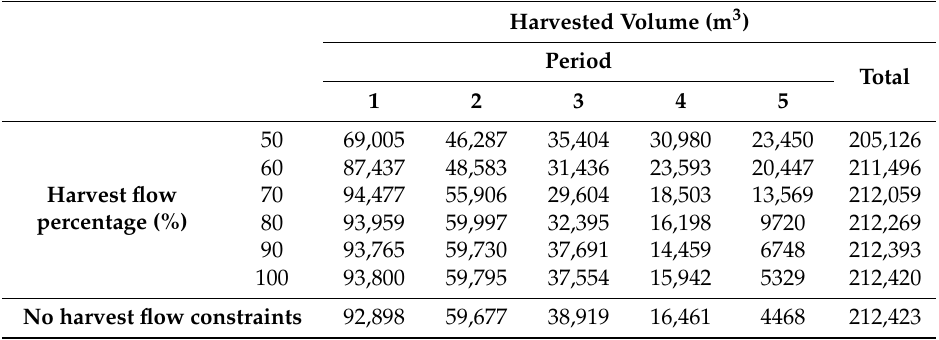
Table 5. The periodic and total harvested volumes for different harvest flow percentages obtained using the ROB model for 50% protection level in the first